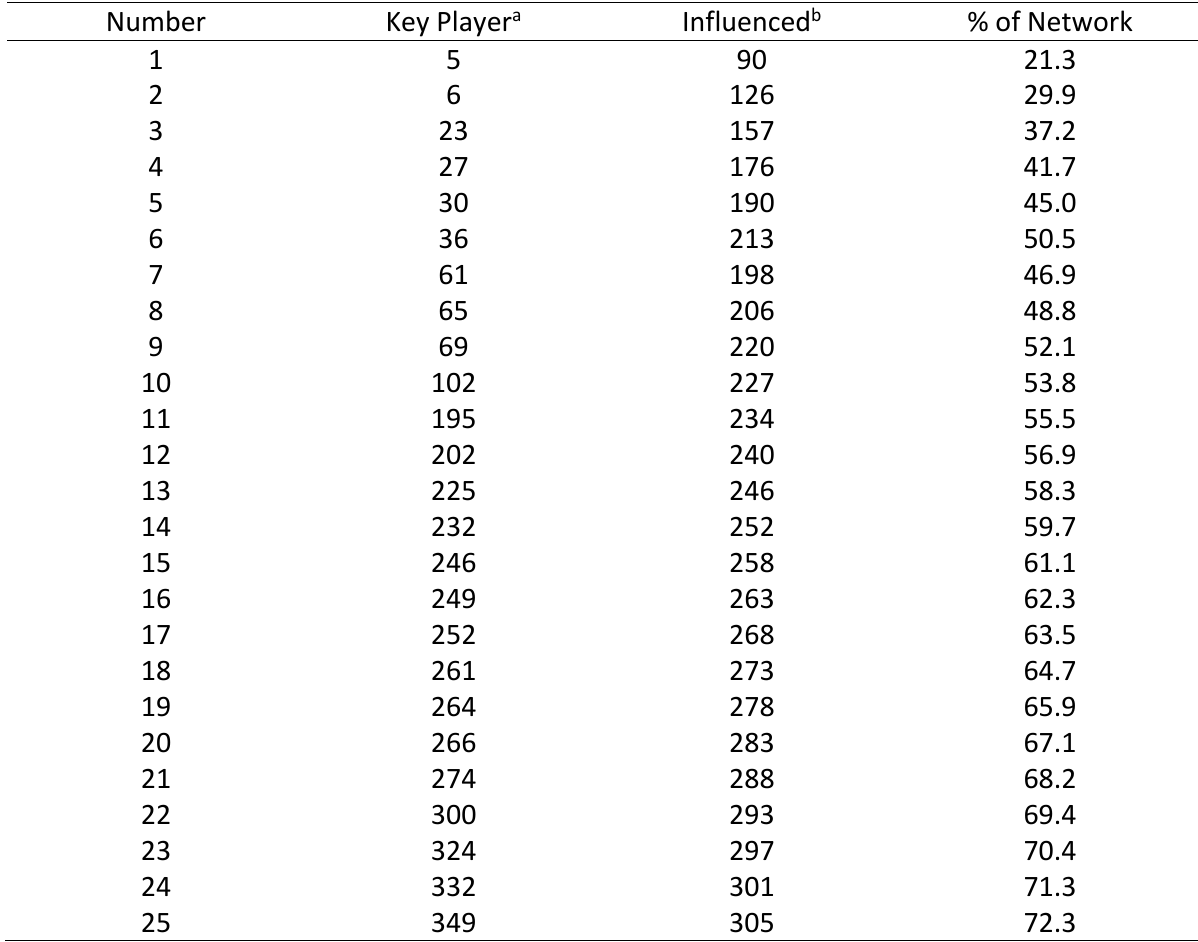
Table 2 Top 25 Key Players in the Turfgrass